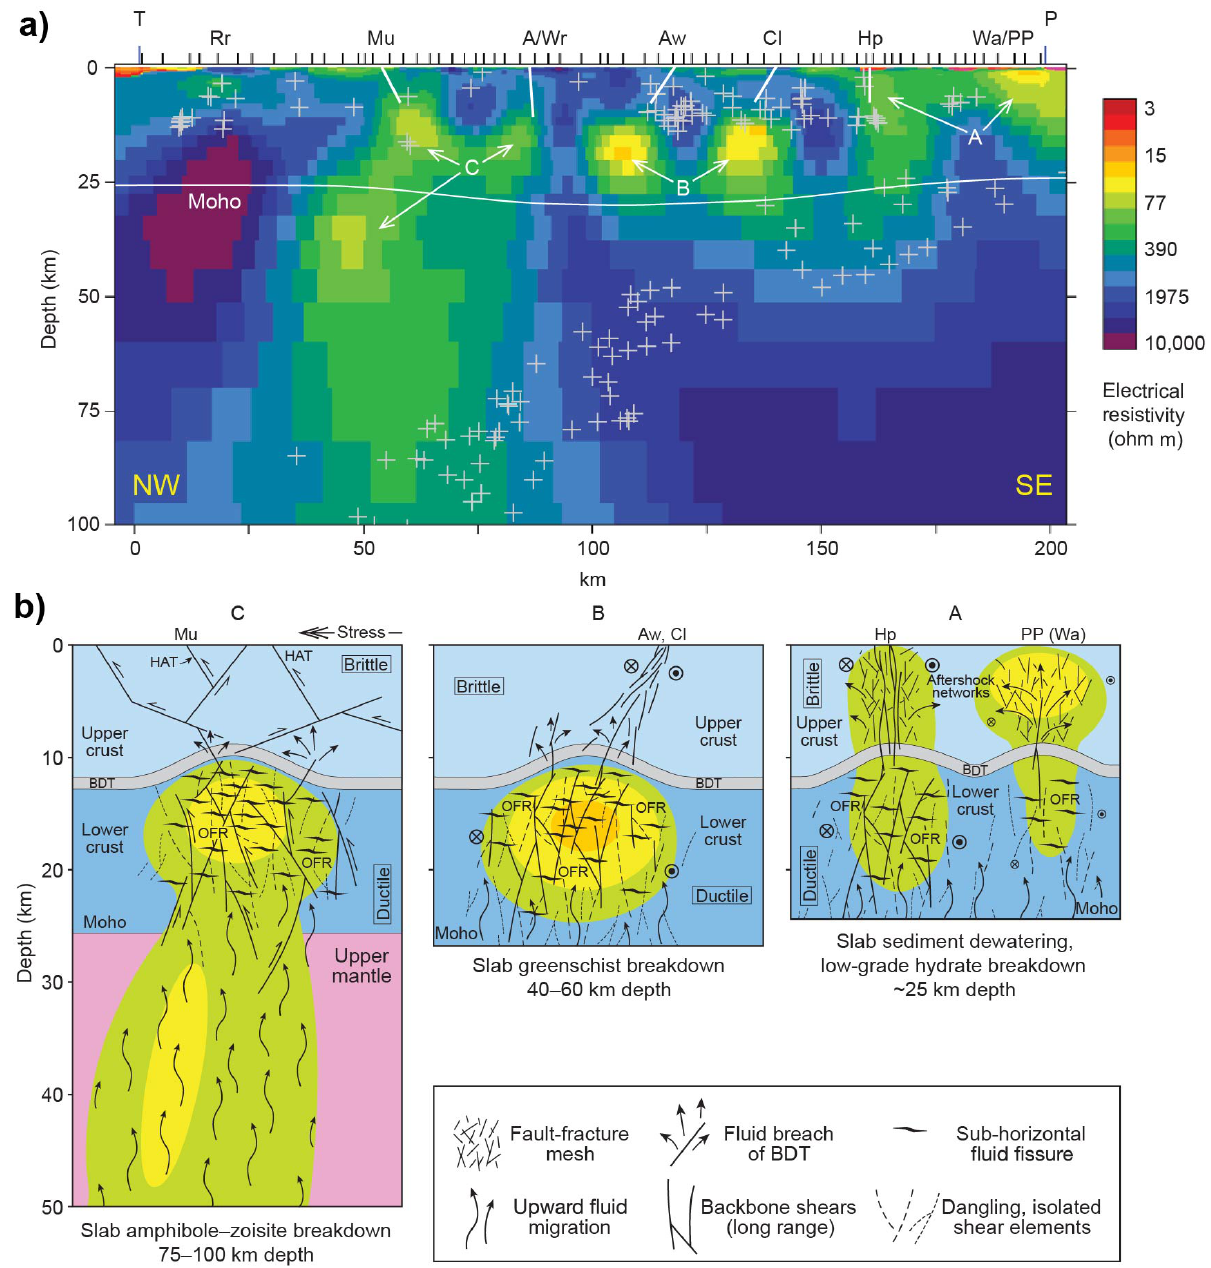
Figure 5. ( a ) MT derived electrical resistivity structure of an advancing subduction system at Marlborough, New Zealand and ( b ) related interpretation of the high-conductivity anomalies af- ter Wannamaker et al. [96]. P denotes the Pacific ocean. Hope (Hp), Clarence (Cl), Awatere (Aw), and Alpine/Wairau (A/Wr) are four strike-slip faults; Murchison (Mu) represents a thrust fault. Plus symbols denote seismicity within 25 km along the MT profile. BDT = brittle–ductile transition; OFR = overpressured fluid reservoir; HAT = high-angle thrust. Green, yellow and orange zones in ( b ) represent the low resistivity zones as imaged in ( a ) NW: Northwest; SE: Southeast. A, B and C represents the high conductive